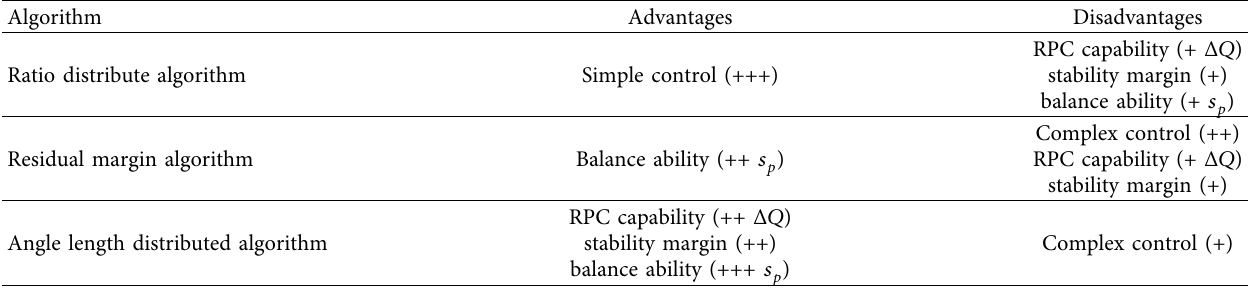
Table 7: Comparison and description of algorithms this paper.